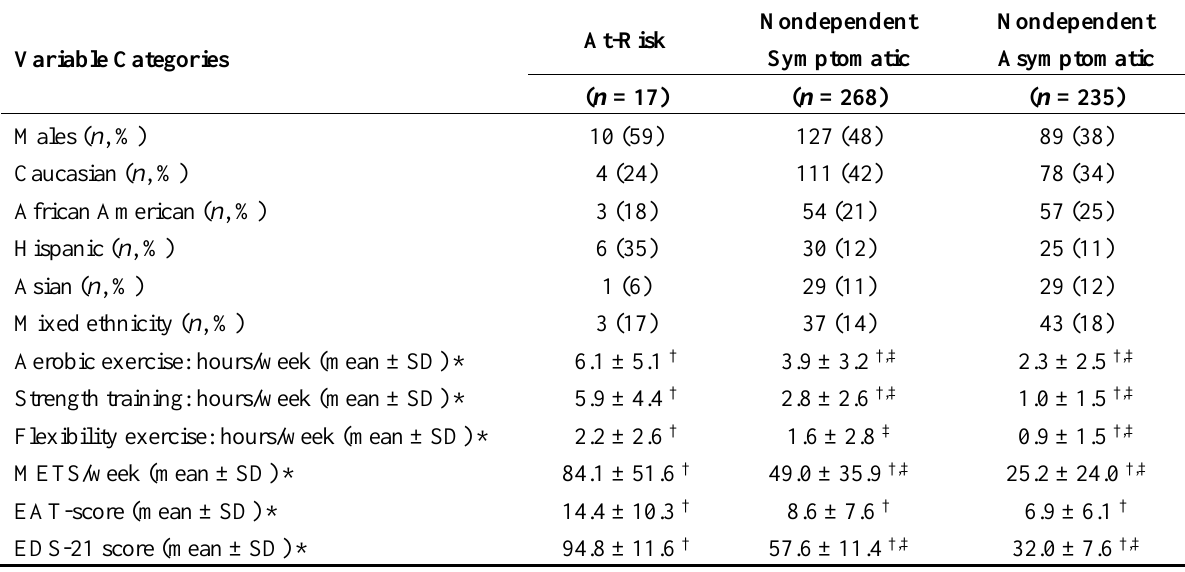
Table 1. Characteristics of participants by their EXD